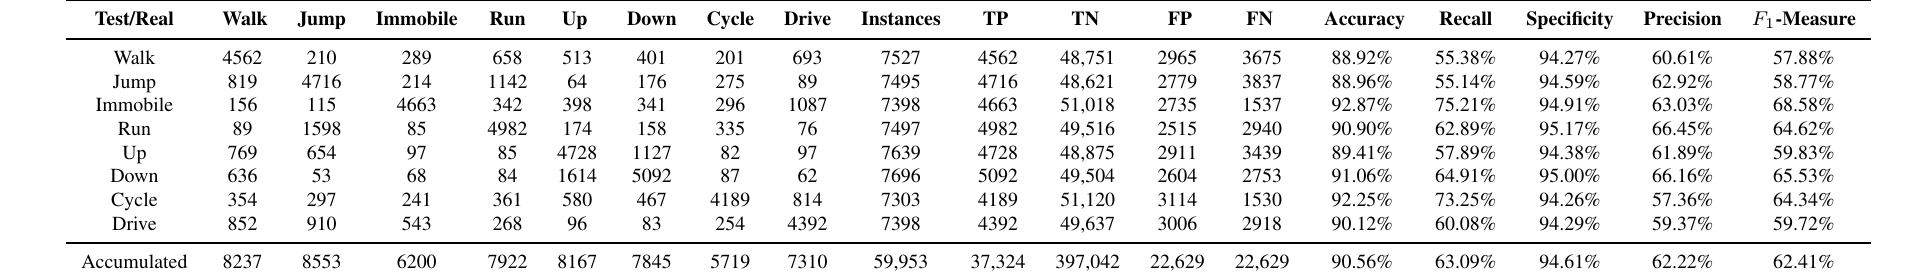
Table B5. Confusion matrix and performance values for the SVM-based classification system.